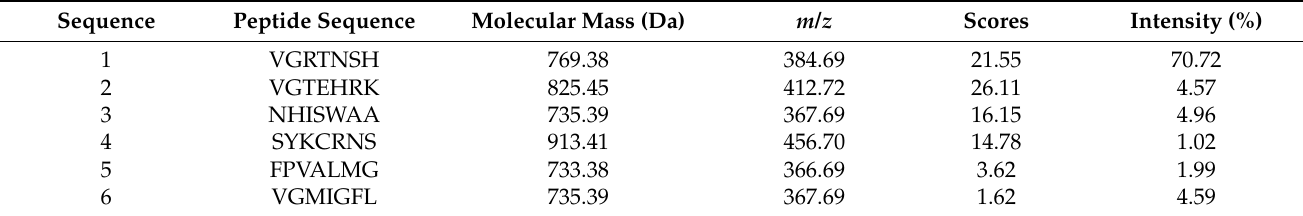
Table 3. Main peptide sequences of UEC4-1.